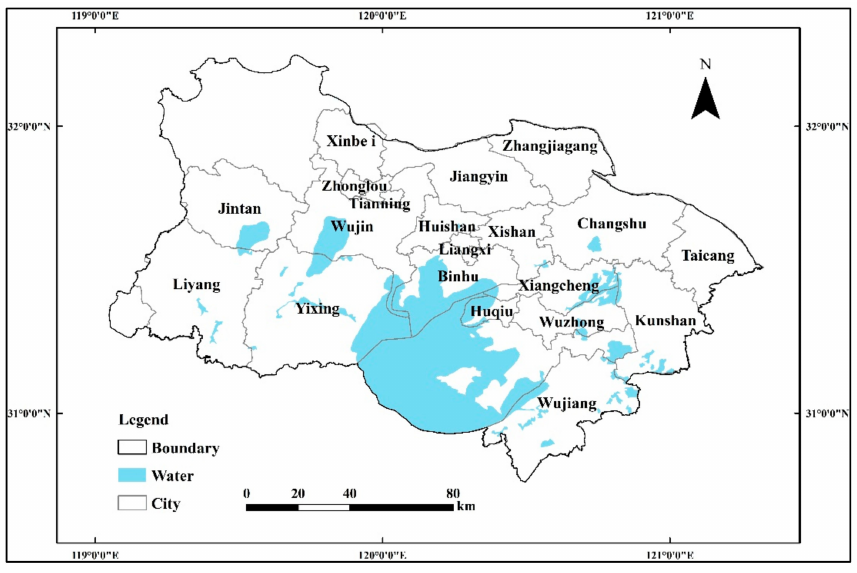
Figure 1. Study area and control section